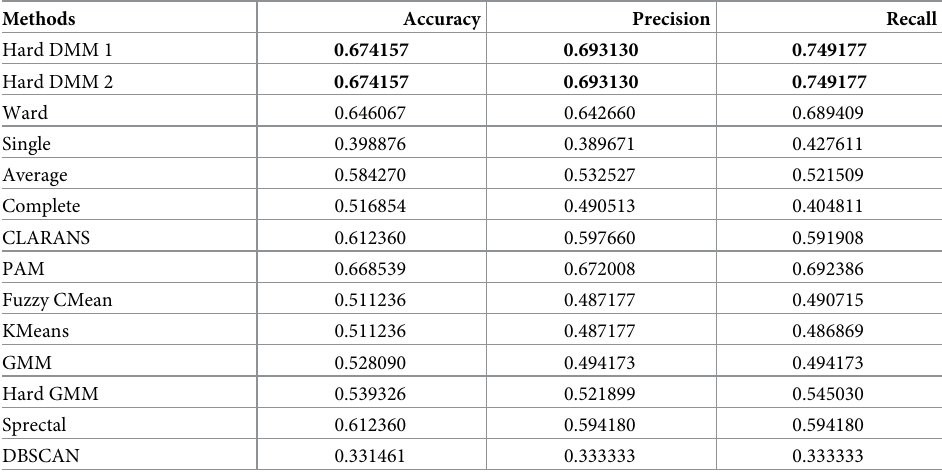
Table 7. Performance comparison of different model based clustering methods on wine